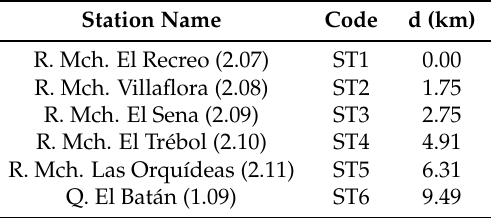
Table 1. Monitoring Stations of Machángara River. ST1 is the first station and d is the distance from each station with respect to the first one. Each monitoring station name is followed by the original code provided by the Metropolitan Water Company of Quito,